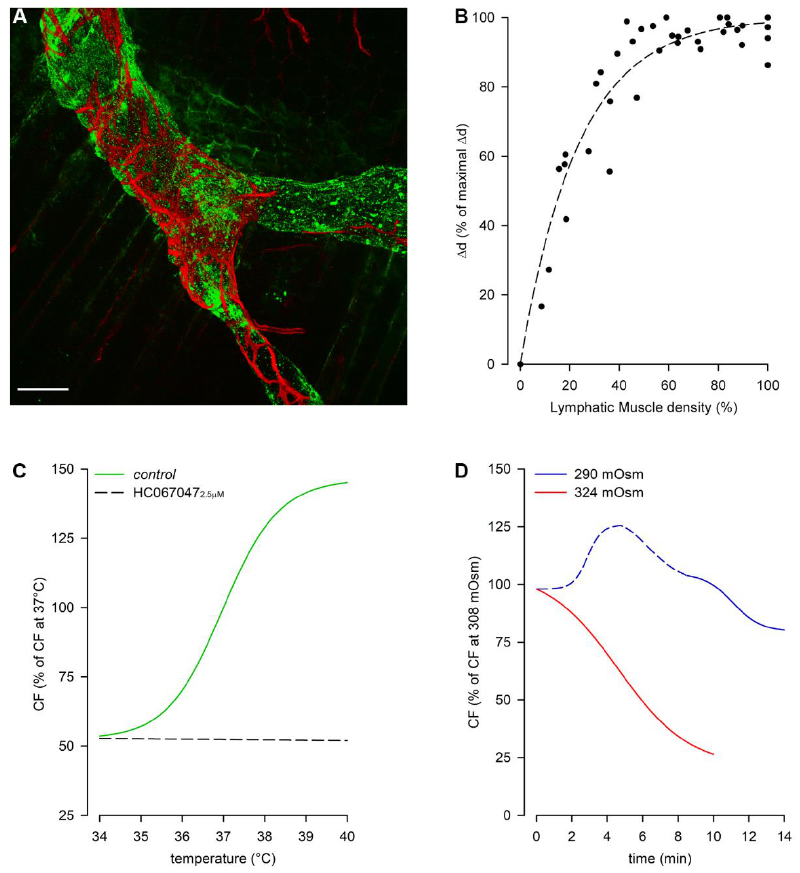
Figure 2. ( A ) Representative confocal image of a rat pleural diaphragmatic lymphatic vessel in vivo stained with FITC-dextrans (green signal) and whole mount stained for LMCs (red signal), high- lighting the organization of the lymphatic muscle mesh surrounding the vessel (scalebar 100 µm). ( B ) Plot of rat diaphragmatic lymphatics intrinsic contraction amplitude (Δd) correlating to the den- sity of lymphatic muscle in the vessels’ wall. ( C ) Plot of the dependence of rat diaphragmatic lym- phatics intrinsic CF from temperature in the range 34 – 40 °C (green trace). Temperature-dependency is completely abolished by the selective TRPV4 channels antagonist HC067047 (2.5 µM, black dashed line). ( D ) Plot of osmolarity-induced modulation of rat diaphragmatic lymphatics intrinsic CF. The hyperosmolar environment (324 mOsm, red trace) induces a sigmoidal decease in CF. Hy- posmolarity induces a two-phase response, as lymphatic vessels display an acute early CF increase (290 mOsm, blue dashed line) followed by a later CF decrease (blue solid line).